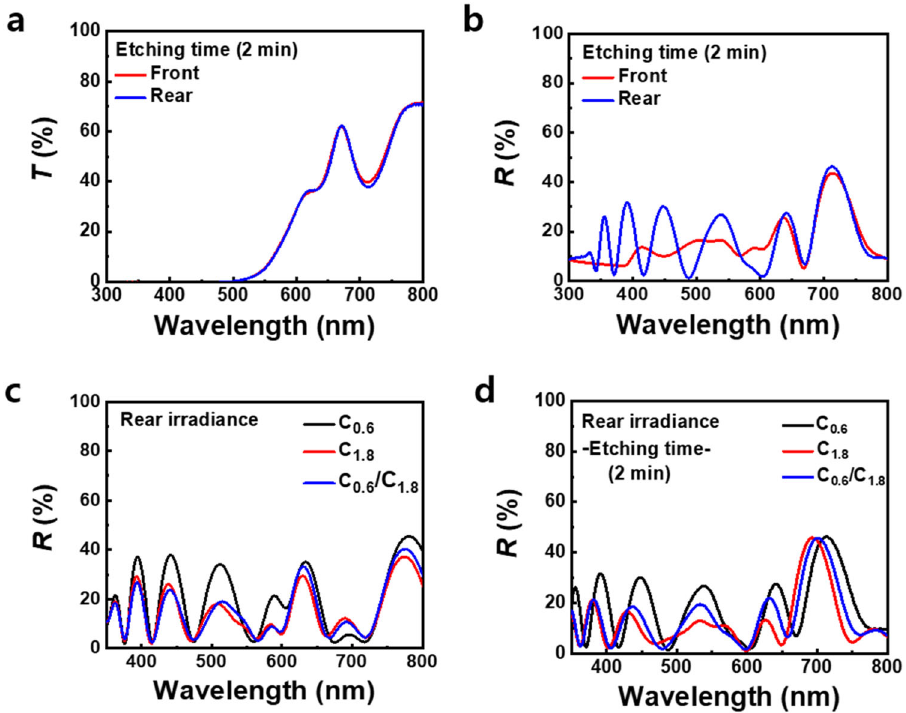
Fig. 5 Optical properties with direction of irradiance. a Transmittance and b re fl ectance spectra of TSC fabricated on T-CPI fi lm with etching time of 2 min (front- and rear-side irradiance). c Simulated and d experimental rear-side re fl ectance spectra of TSCs prepared on T-CPI. Experimental spectra refer to etching time of 2 min and three different structures (C 0.6 , C 1.8 , and C 0.6 /C 1.8 ) of n-type hydrogenated microcrystalline silicon oxide (n- μ c-SiO x :H).